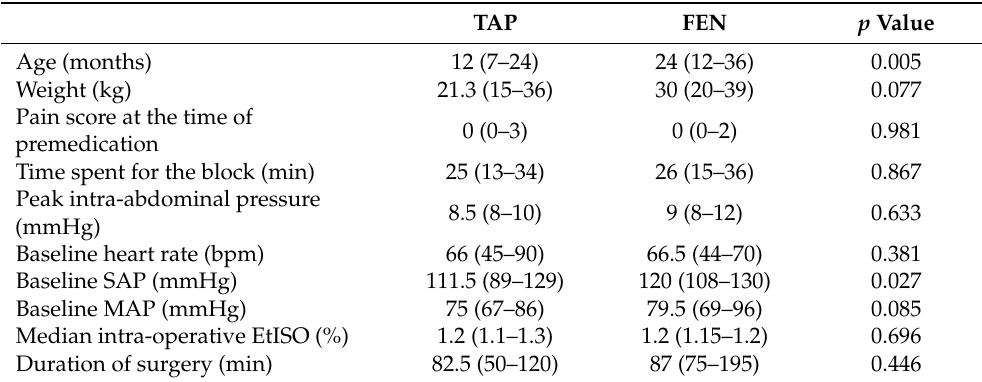
Table 1. Demographic data, time spent for the block, peak abdominal pressure, baseline hemo- dynamic values, median intra-operative EtISO and duration of surgery. Values expressed as median (range).